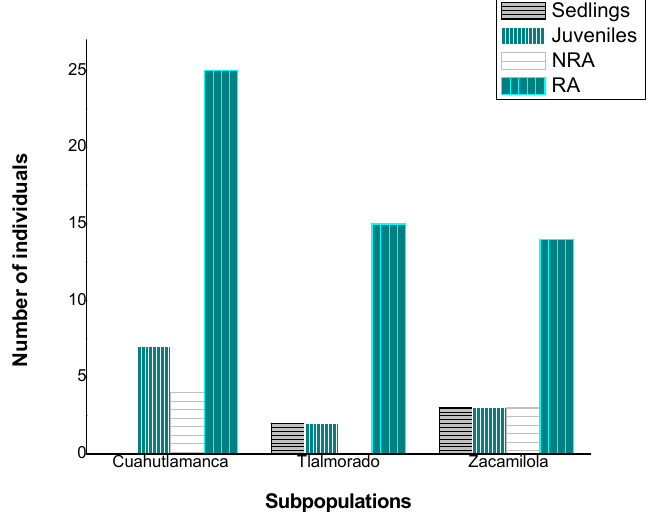
Figure 10. Age and sex population structure in three subpopulations of Atlahuilco.